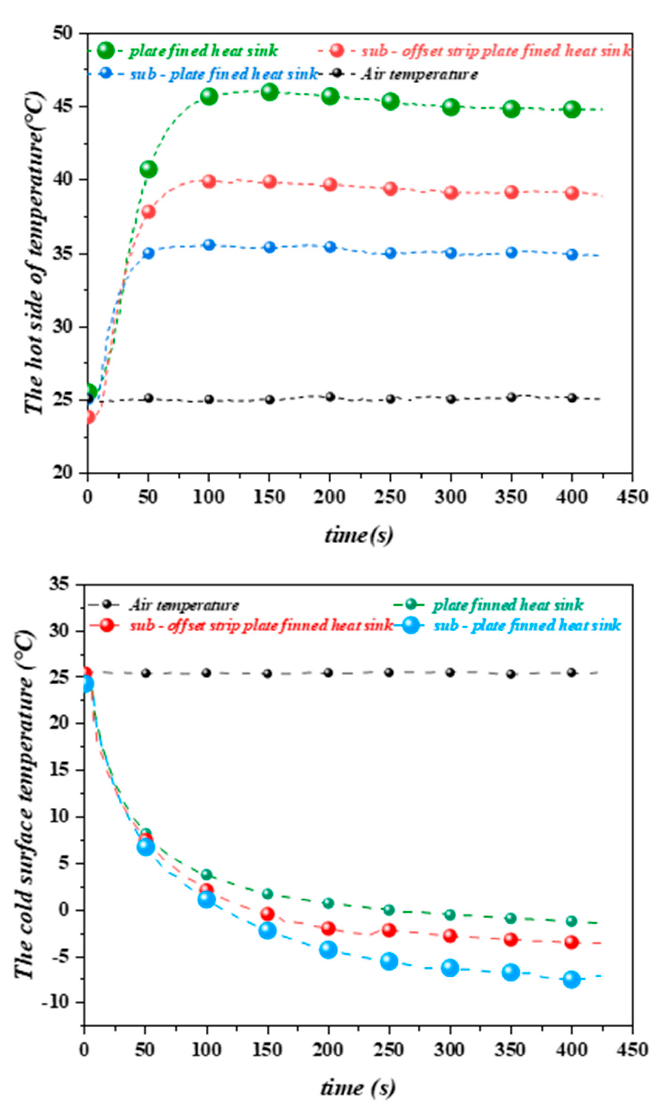
Figure 4. Temperature diagram of hot and cold surface of TEC module under three kinds of heat sinks ( I = 5 A, U = 7.5 m/s ) .